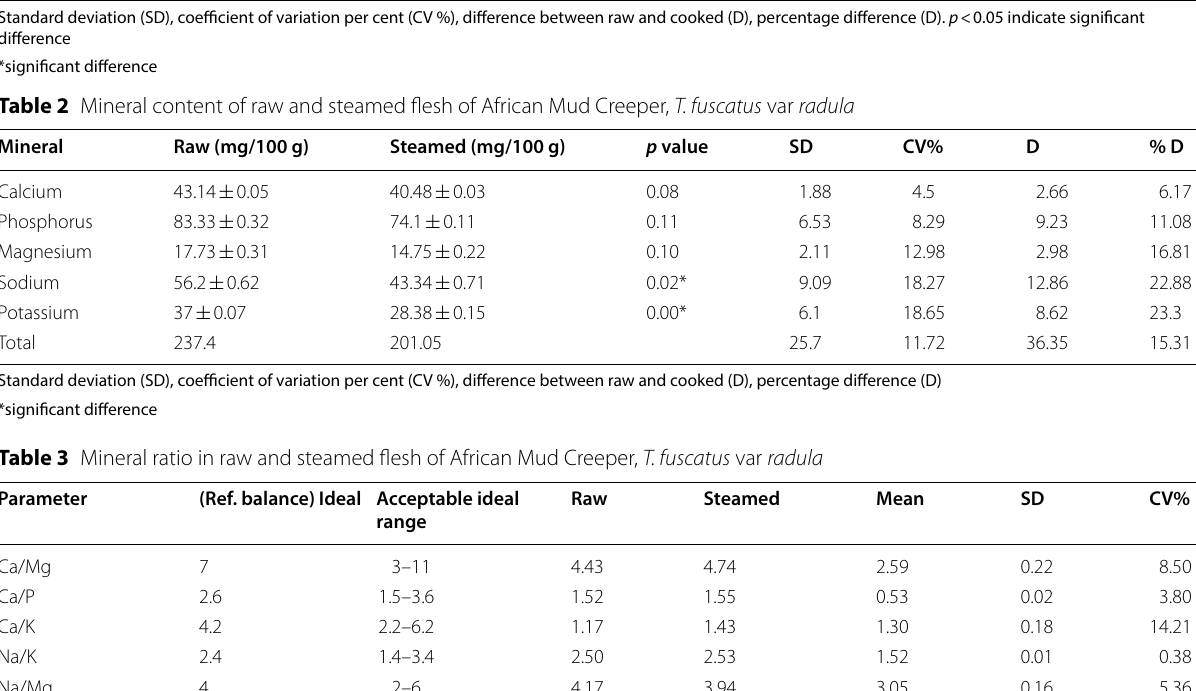
Standard deviation (SD), Coefficient of variation per cent